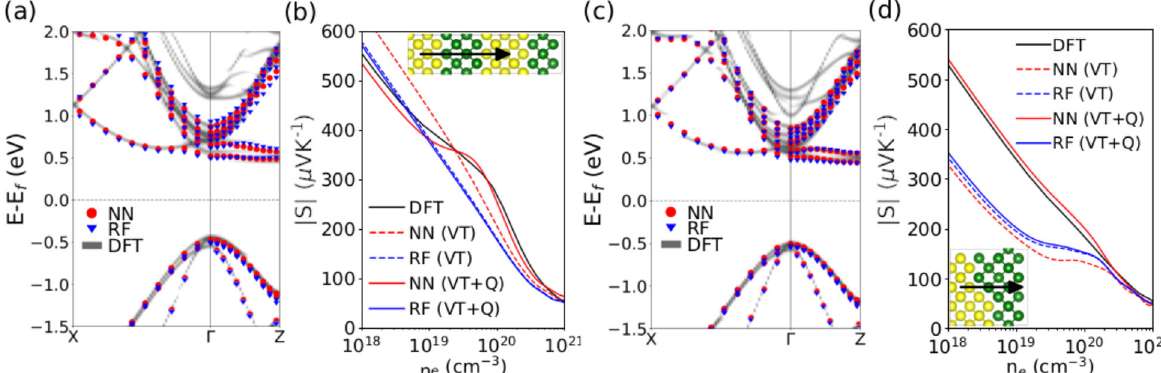
Fig. 5 Performance of ML algorithms on larger non-ideal heterostructures. a Effective band structure (EBS) (gray) of Si 4 Ge 4 Si 5 Ge 3 multilayered system compared with ML-predicted bands. b Thermopower calculated from DFT (black) and ML bands (NN-red and RF-blue). c EBS of an imperfect layer heterostructure (gray) compared with predicted bands. d Thermopower calculated from DFT (black) and ML bands (NN-red and RF-blue). Insets show representative test structure con fi gurations. Dashed and solid lines represent predictions from ML models, trained with all Voronoi tessellations (VT) derived features except order parameters (Q), and including them (VT + Q),